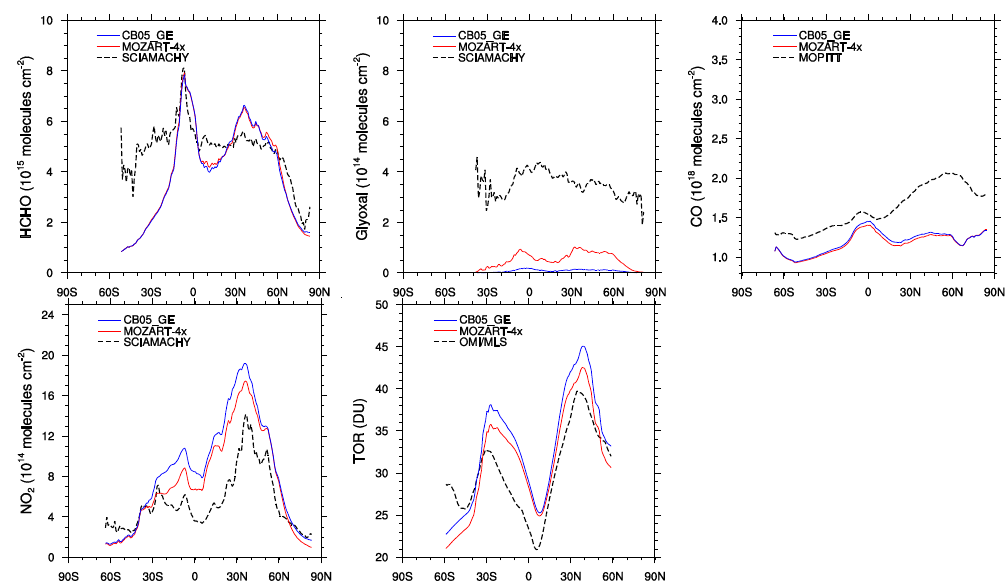
Figure 3. Zonal-mean profiles of HCHO, glyoxal, CO, NO 2 , and TOR from CB05_GE and MOZART-4x simulations for June, July, and August during